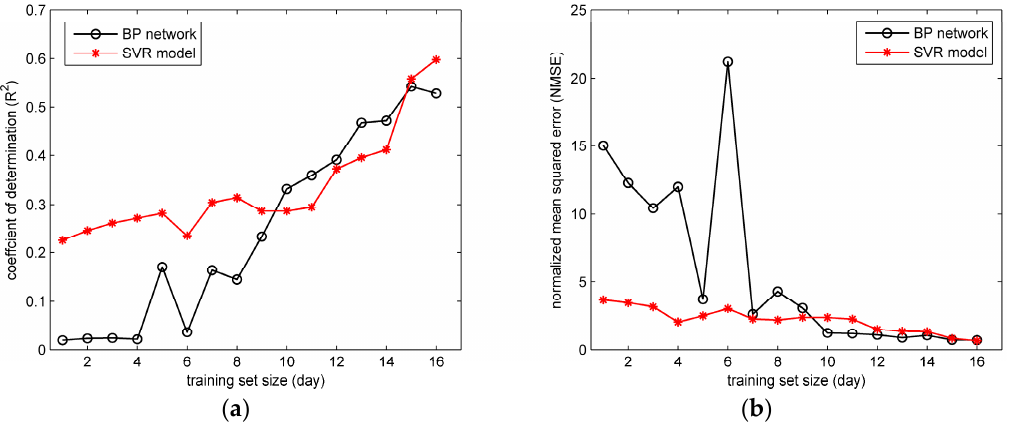
Figure 11. The performances of BP network and SVR model with training sets of different scales in the Indianapolis case: ( a ) the coefficient of determination ( R 2 ); ( b ) the normalized mean squared error (NMSE).